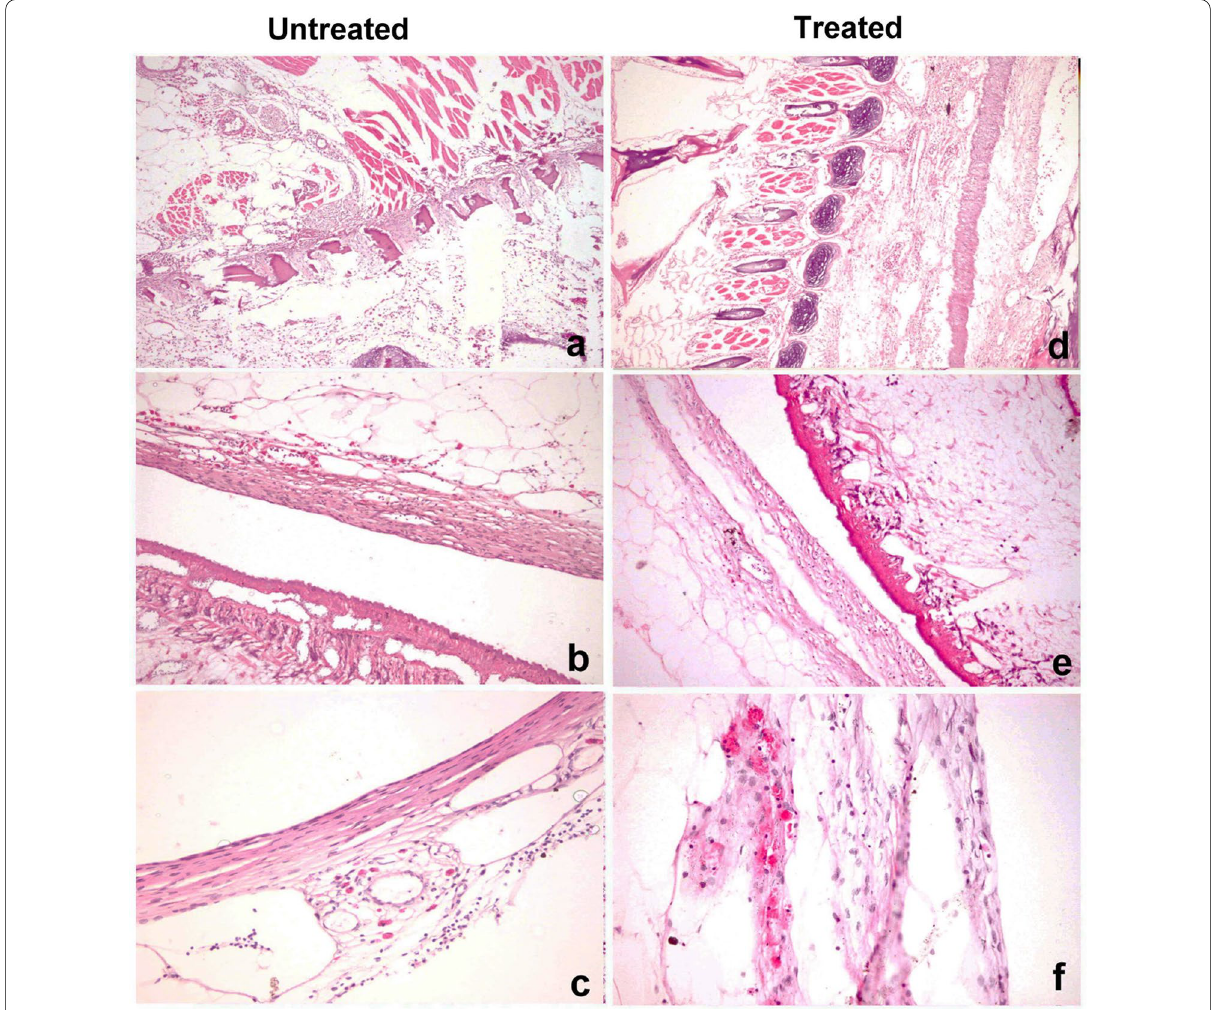
Fig. 5 a c Histological section of fish pseudobranch of control untreated group showing; a Massive destruction of bony tissue and muscle − fiber with intense inflammatory cells infiltration ( 100). b Compact fibrous bundles of the cyst wall ( 200) c Intense EGCs infiltration mixed with × × mononuclear cells in the adipose tissue that incorporated in the structure of cyst wall ( 200). d – f Histological section of fish pseudobranch of × treated group showing, d histologically normal of pseudobranch bony structures and muscle bundles with few EGCs infiltrating the underlying adipose tissue ( 100). e Depression of fibrous bundles of cyst wall with minim al reaction od of the adjacent host adipose tissue( 100). f massive × × dispersions and edema of the cyst wall fibrous structure with degranulation of EGCs ( ×